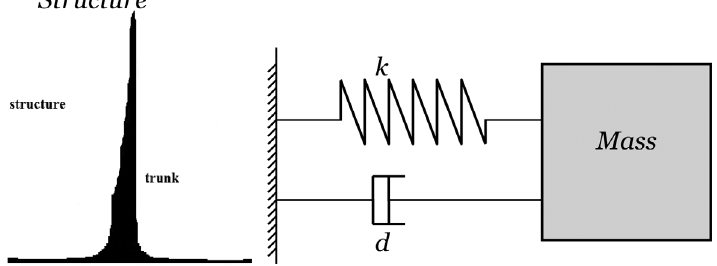
Fig. 1. Dynamic model of a tree trunk (structure) represented as a mass ( m ) oscillating on a spring ( k ) with the motion being damped ( d ).